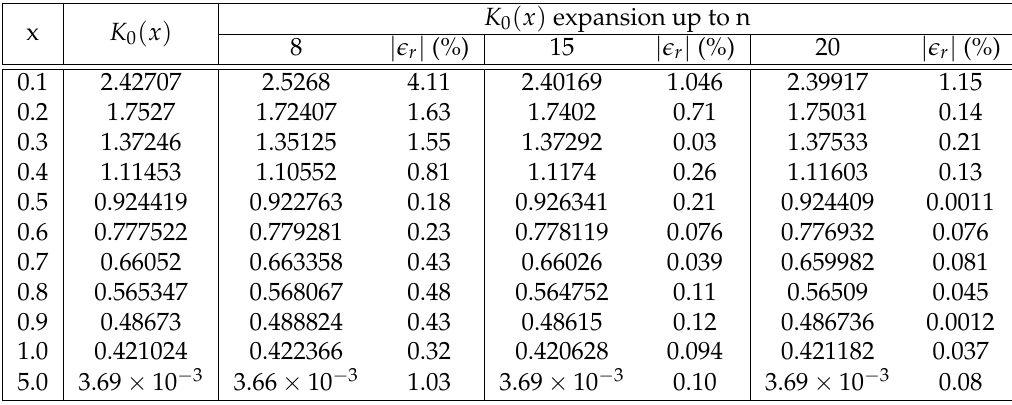
Table 2. Values for K 0 ( x ) expansion given by Equation (5) for different n